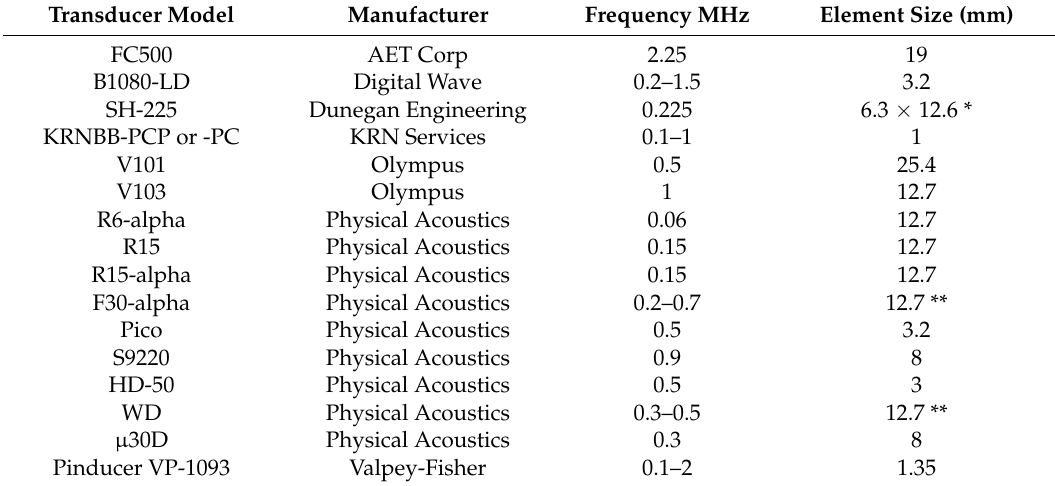
Table 1. Transducers used.